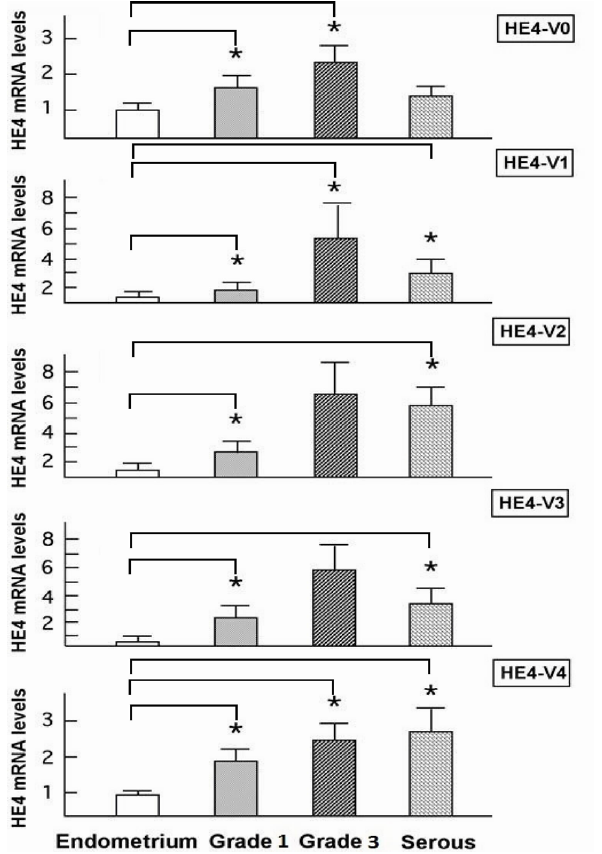
HE4 variants were measured in normal endometrium, grade 1 and 3 endometrioid cancer, and serous cancers by real-time PCR. HE4 mRNA levels in normal endometrium were set as 1. Statistical significance ( p < 0.05) was indicated by